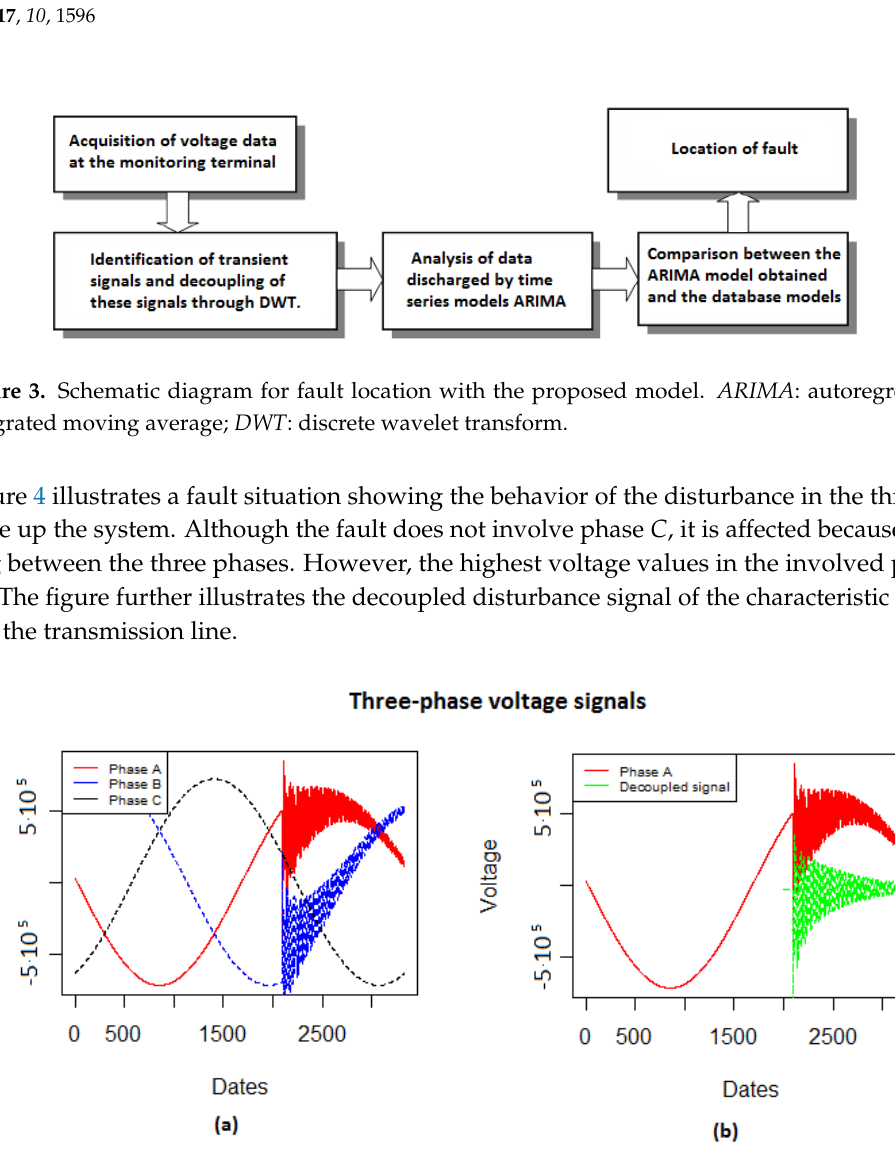
Figure 4. ( a ) Voltage signals with incident angle of 90 ◦ and fault resistance of 240 Ω at a distance of 10 km from the monitoring terminal; ( b ) Disconnected disturbance